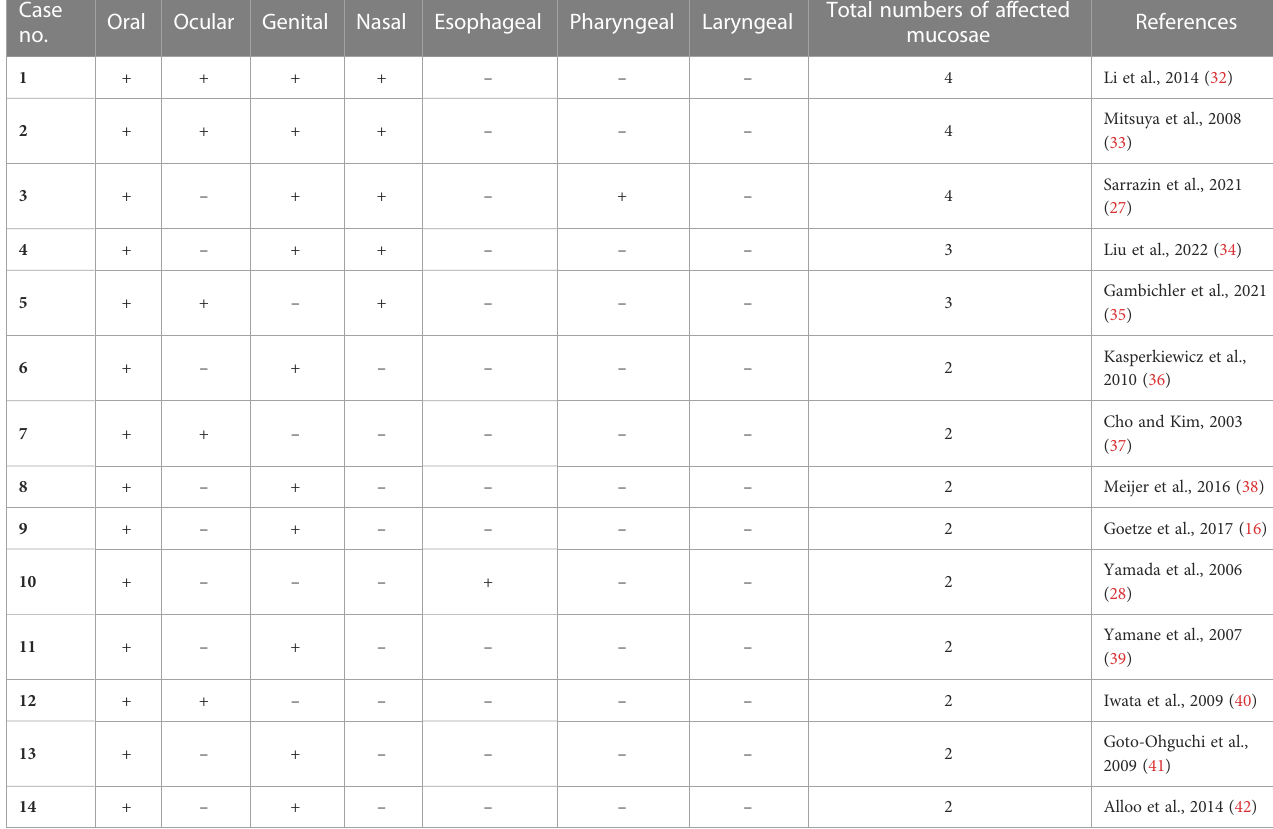
TABLE 3 Mucosal lesions distribution of 14 anti-p200 pemphigoid patients with multiple sites of mucosal lesions. Case